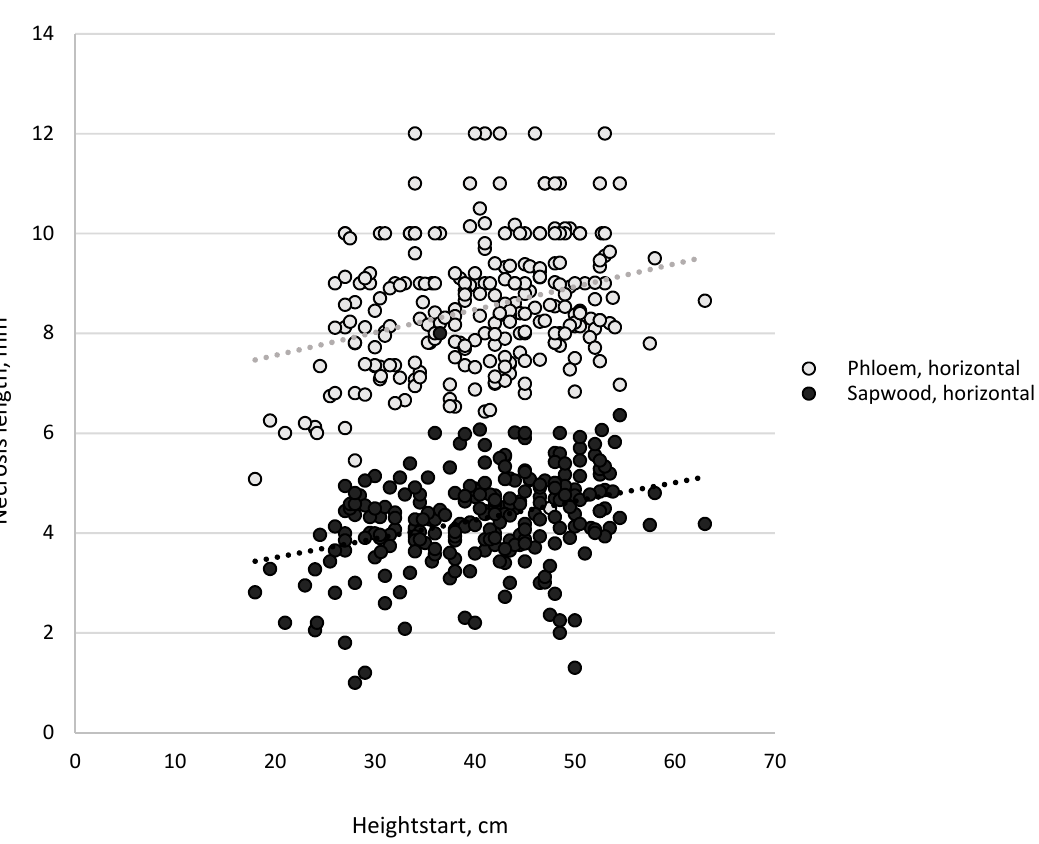
Figure 6. Combined horizontal necrosis length of H. parviporum and H. annosum correlated positively with seedling height at the start of the experiment. Higher seedling height indicates higher horizontal necrosis length.